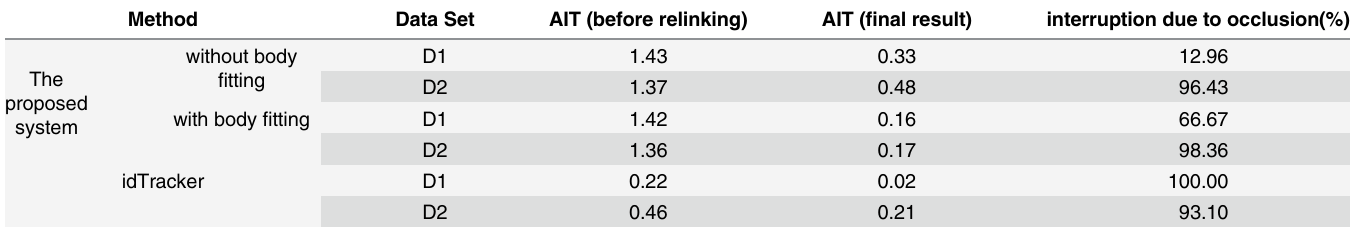
Table 6. AIT of the proposed system and